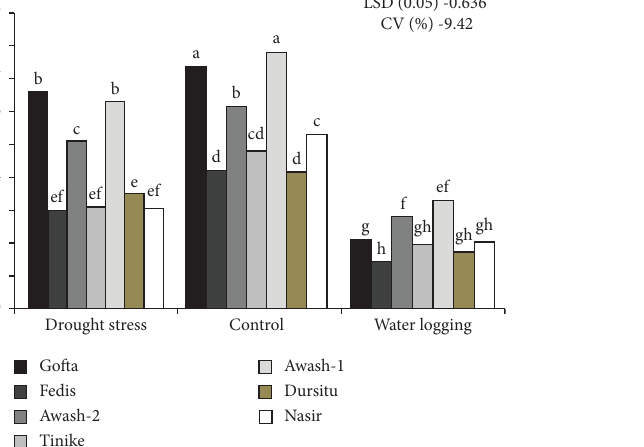
Figure 5: Interaction efects of common bean varieties and irrigation interval on grain yield under lath house 2020.